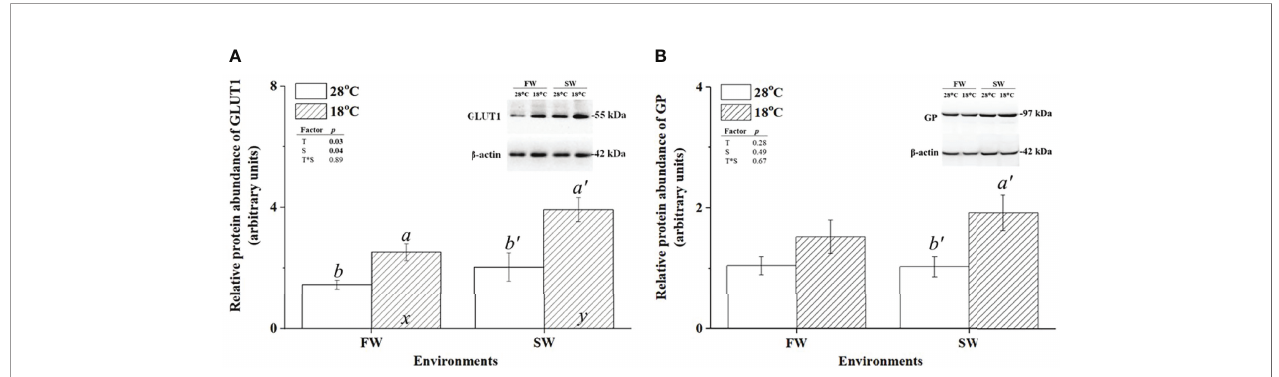
FIGURE 2 | Relative protein abundance of branchial glucose transporter 1 (GLUT1) and glycogen phosphorylase (GP) in freshwater (FW)- and seawater (SW)- acclimated milk fi sh at 28°C (white bar) and 18°C (striped bar). Representative immunoblots of GLUT1 (A) and GP (B) show a single immunoreactive band. The single immunoreactive band of b -actin at 42 kDa was used as the loading control. Different letters in the FW milk fi sh (a, b) and SW milk fi sh (a ’ , b ’ ) indicate signi fi cant differences between the normal and low-temperature groups. The x and y indicate signi fi cant differences between the FW and SW groups at 28°C or 18°C. Values represent the mean ± standard error of the mean (SEM), n = 9, P < 0.05.